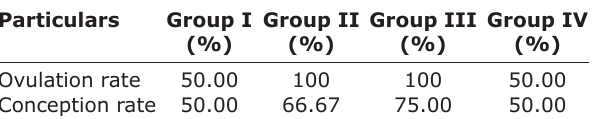
Table-6: Effect of herbal supplementation on ovulation and conception rate in delayed pubertal buffalo heifers after herbal